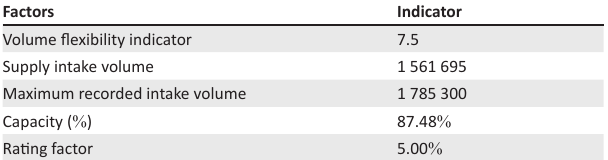
TABLE 16: Supply volume flexibility.